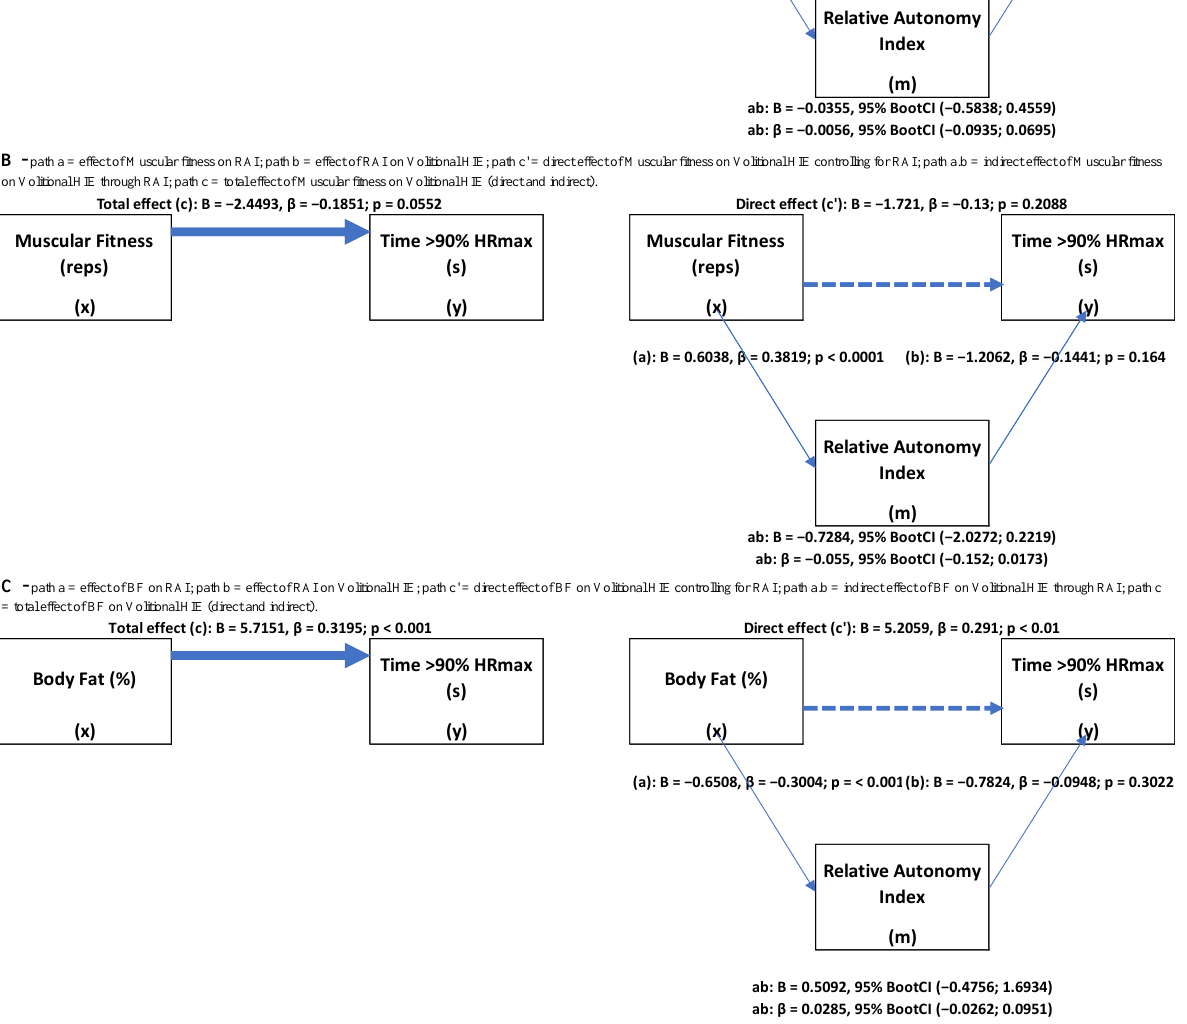
Figure 3. Mediation models showing the effects (total, direct and indirect) of physical fitness variables on volitional high-intensity exercise. The bootstrap-derived 95% confidence intervals included zero for all outcomes me- diated through motivation, revealing a non-significant, indirect effect of physical fitness through motivation on exercise intensity, specifically on CRF (B = −0.0355, 95% BootCI [−0.5838; 0.4559] ; R 2 = 0.17; post hoc power = 1 ), muscular fitness (B = −0.7284, 95% BootCI [−2.0272; 0.2219] ; R 2 = 0.08; post hoc power = 0.86) and body fat (B = 0.5092, 95% BootCI [ − 0.4756; 1.6934]; R 2 = 0.10; post hoc power = 0.93). There were direct effects ( path c’ ) of CRF ( p < 0.0001) and body fat ( p < 0.01) on exercise intensity, suggesting that high values of CRF decrease volitional exercise intensity and high values of body fat increase physical exercise intensity, without mediation through